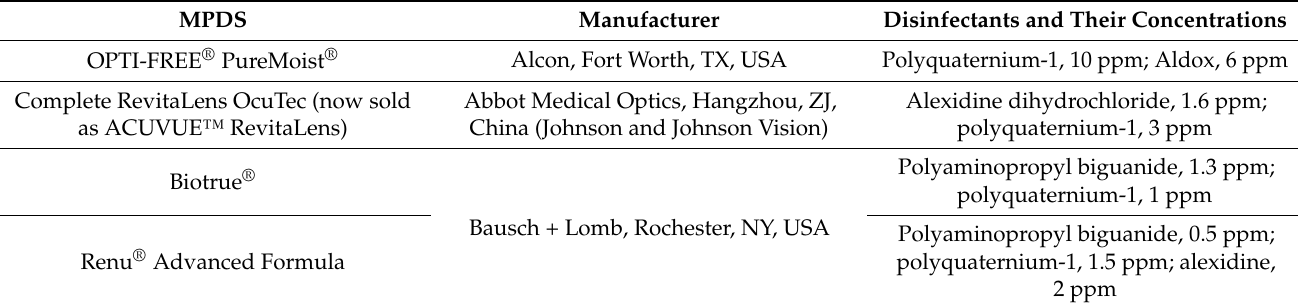
Table 5. Multipurpose disinfecting solutions and their active